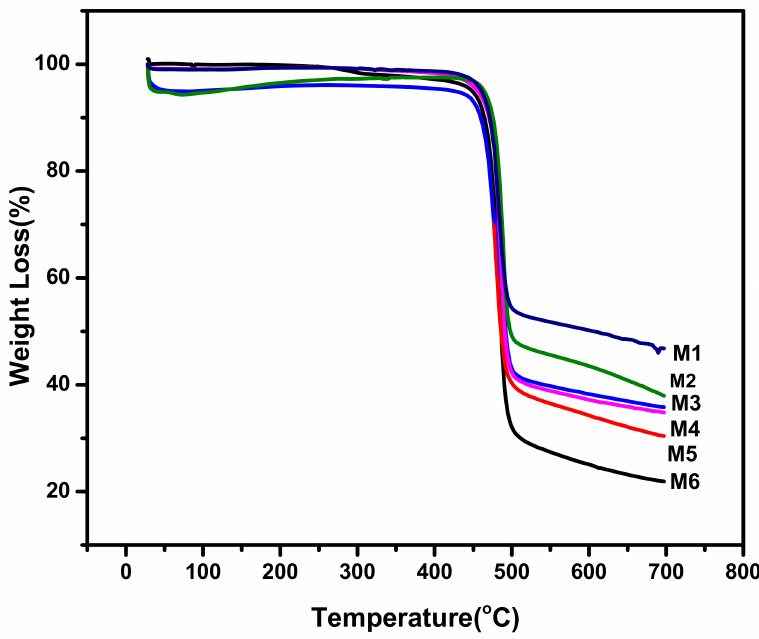
Figure 8. TGA graph of aminated graphene oxide–based PVDF